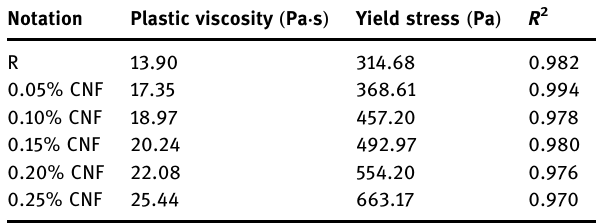
Table 3: Rheological parameters of the UHPC